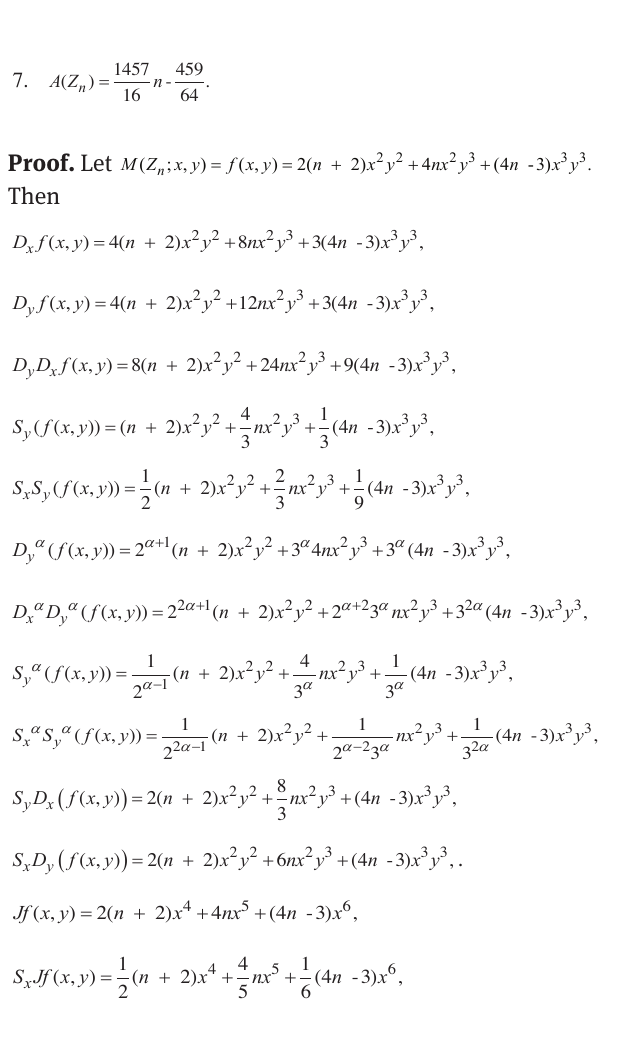
Figure 3: The plot for the M-polynomial of 1 Z